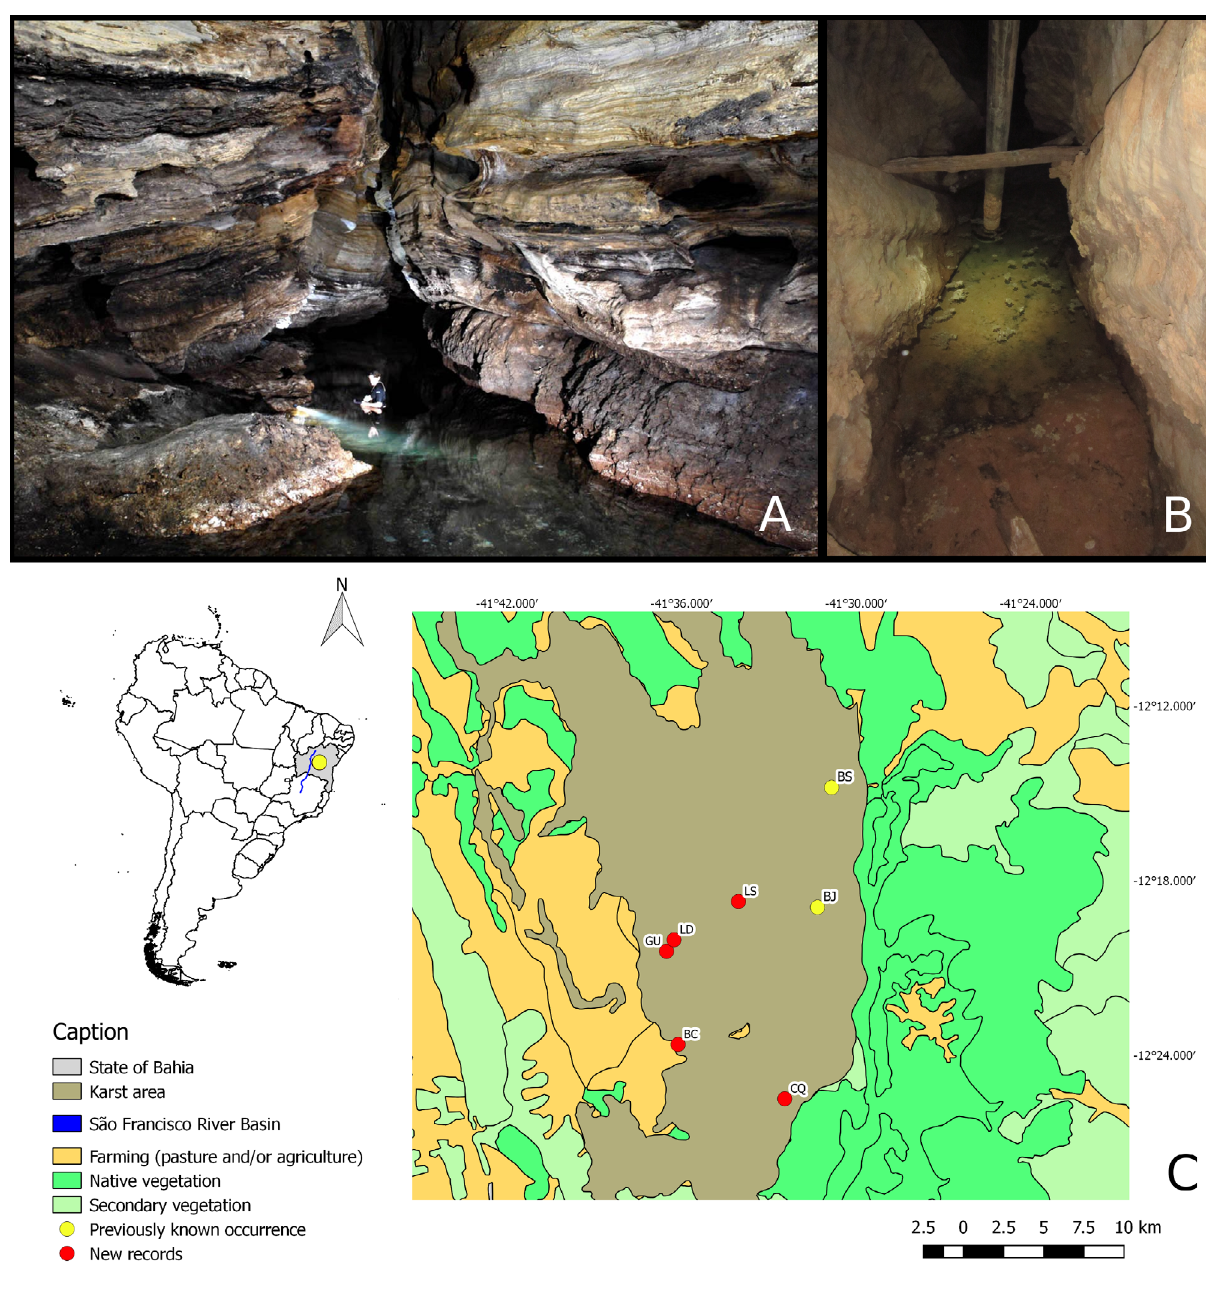
Figure 7. Lake formed by upper phreatic aquifer at Canoa Quebrada cave ( A ); small pool of upper phreatic aquifer at Lapa Doce System ( B ); distribution of Spelaeogammarus spinilacertus Koenemann and Holsinger, 2000, indicating caves with records of the species showing the land use and land cover of the area ( C ). Caption: LD = Lapa Doce System, GU = Gruta da Umburana cave, LS = Gruta da Lagoa Seca cave, BC = Buraco do Cão cave, CQ = Canoa Quebrada cave, BS = Baixa do Salitre cave, and BJ = Jaburu cave. Photographs: ( A ) Adriano Gambarini, ( B ) Jonas E.